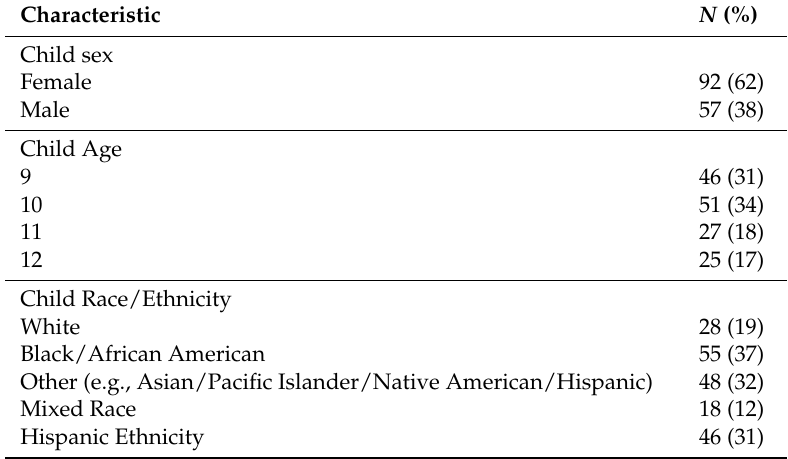
Table 1. Number and percent of participants by sex, age, and race/ethnicity ( n =